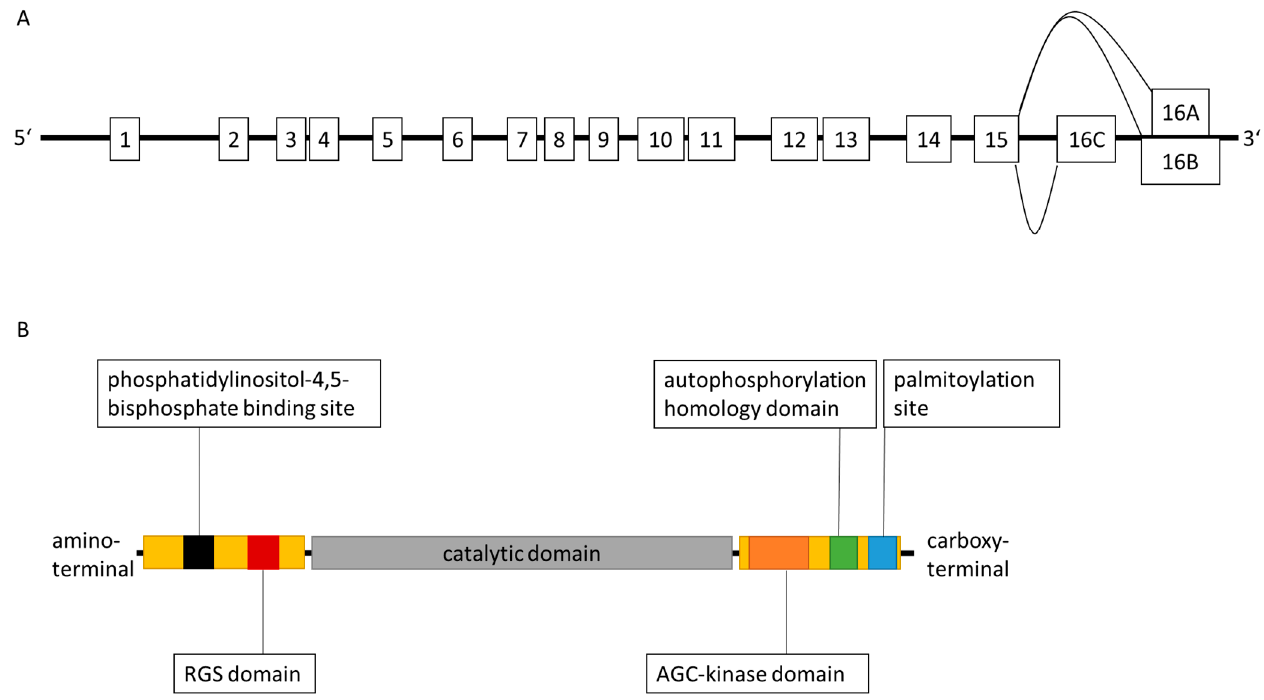
Figure 3. ( A ) Schematic overview of GRK6 gene structure and carboxy-terminal region with alternative splicing of variants GRK6A, B and C. The boxes depict exons. Simplified chart [4]. ( B ) Schematic overview of GRK6 protein structure, simplified chart [29]. The amino-terminal domain contains a phosphatidylinositol-4,5-bisphosphat binding site as well as a regulator of G protein signaling binding domain (RGS domain). This domain is also used for phosphorylation of G protein-coupled receptors and inhibition of receptor signaling [40]. The carboxy-terminal region contains an AGC-kinase domain, which is highly conserved in several serine-threonine kinases [41]. GRK6 also contains an autophosphorylation homology domain similar to GRK5, albeit, even in presence of phospholipids autophosphorylation was not detected in GRK6 proteins [42]. Finally, the GRK6A splice variant undergoes palmitoylation at the carboxy ‐ terminus [30,31].